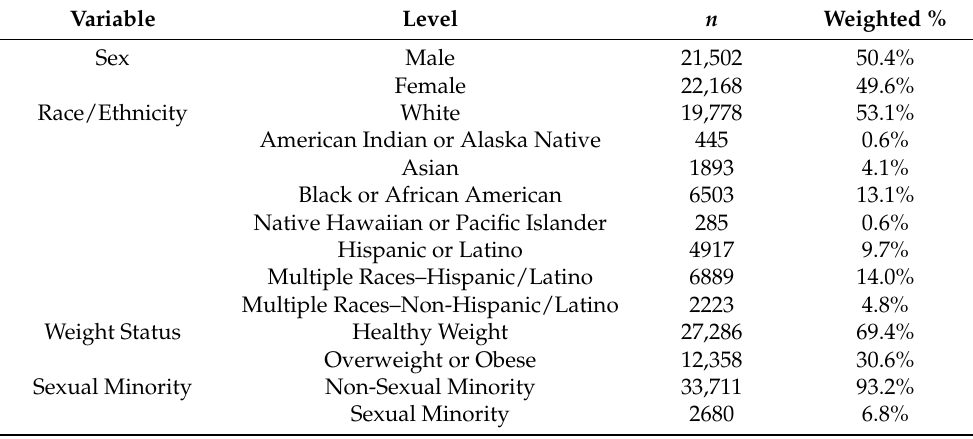
Table 1. Sample demographic characteristics from the combined 2015–2019 Youth Risk Behavior